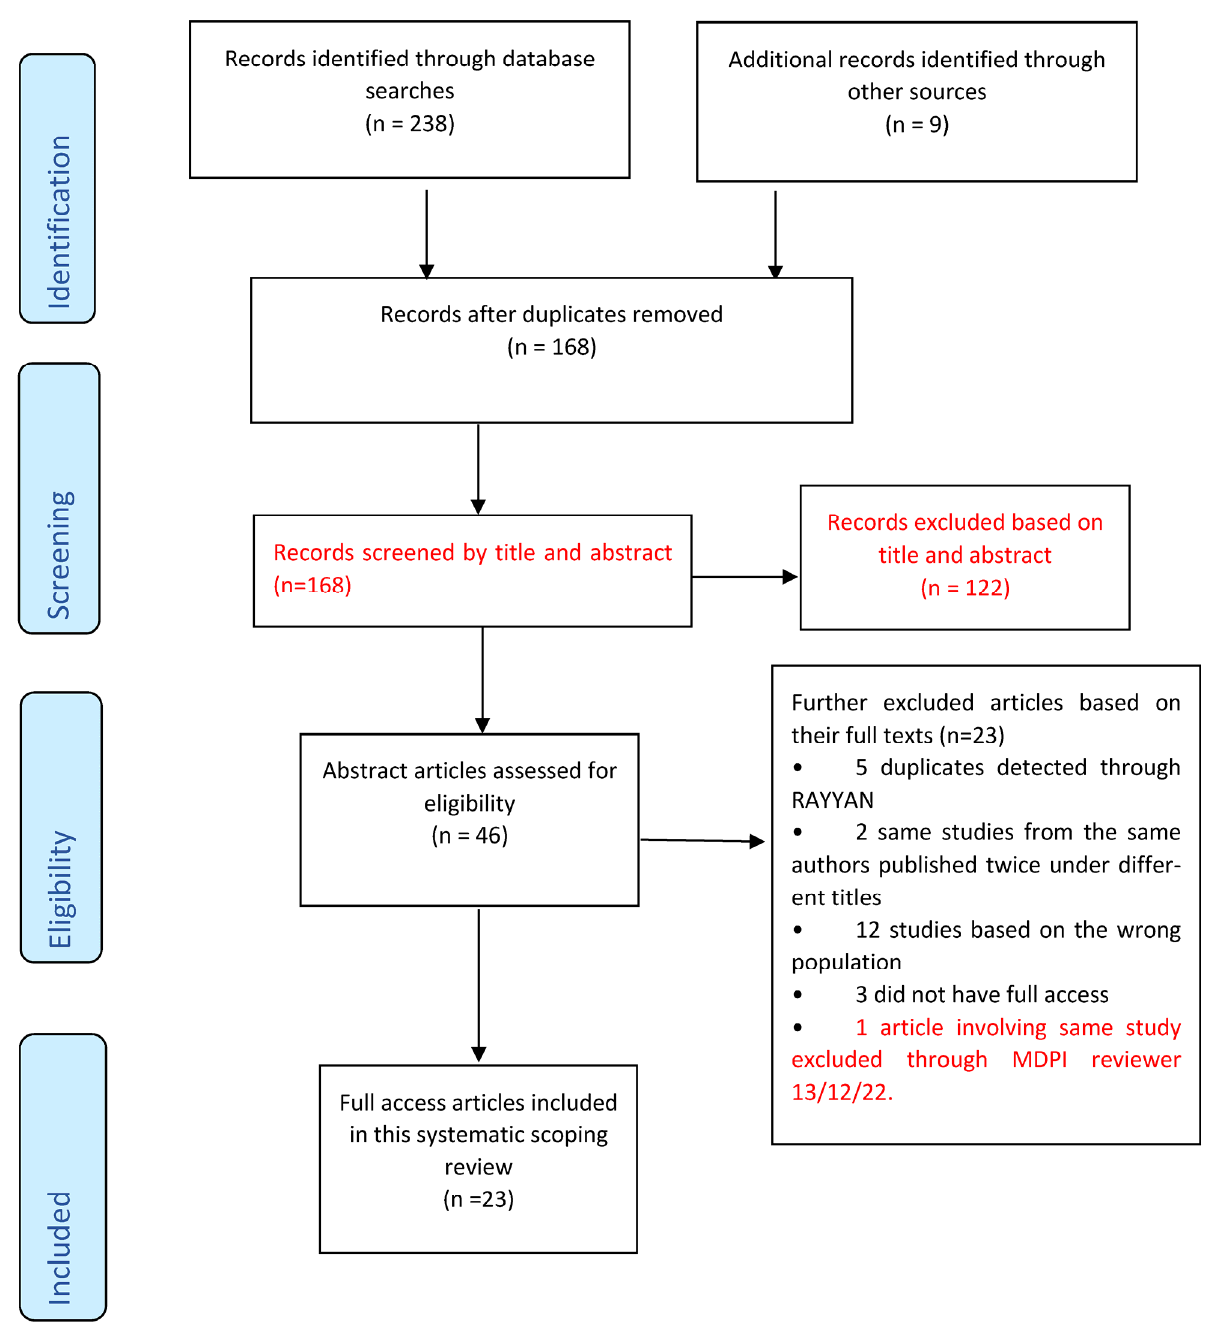
Figure 1. PRISMA-ScR flow chart adapted from Tricco et al. [22].